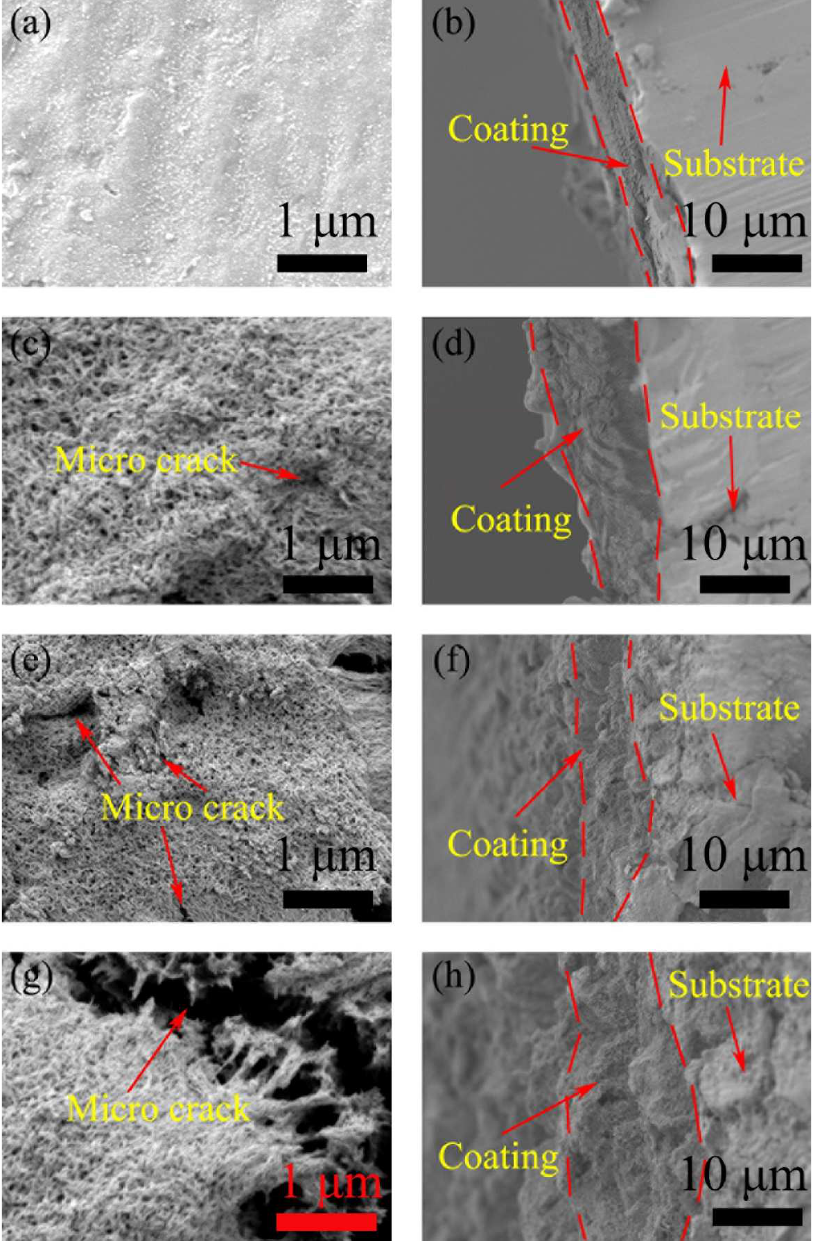
Figure 1. Micro surface and cross-section of Cu 2 O/Al 2 O 3 coating. ( a ) Micro surface and ( b ) cross-section of Cu 2 O/Al 2 O 3 coating without heating; ( c ) micro surface; ( d ) cross-section of Cu 2 O/Al 2 O 3 coating heating at 200 °C; ( e ) micro surface and ( f ) cross-section of Cu 2 O/Al 2 O 3 coating heating at 300 °C; ( g ) micro surface and ( h ) cross-section of Cu 2 O/Al 2 O 3 coating heating at 400 °C. 2.2. Elements and Crystalline Structure Analysis of the Cu 2 O/Al 2 O 3 Coating Image J software was used to study the distribution of pore sizes on the Cu 2 O/Al 2 O 3 coating before and after being heated at 300 °C; the results were shown in Figure 2a. It